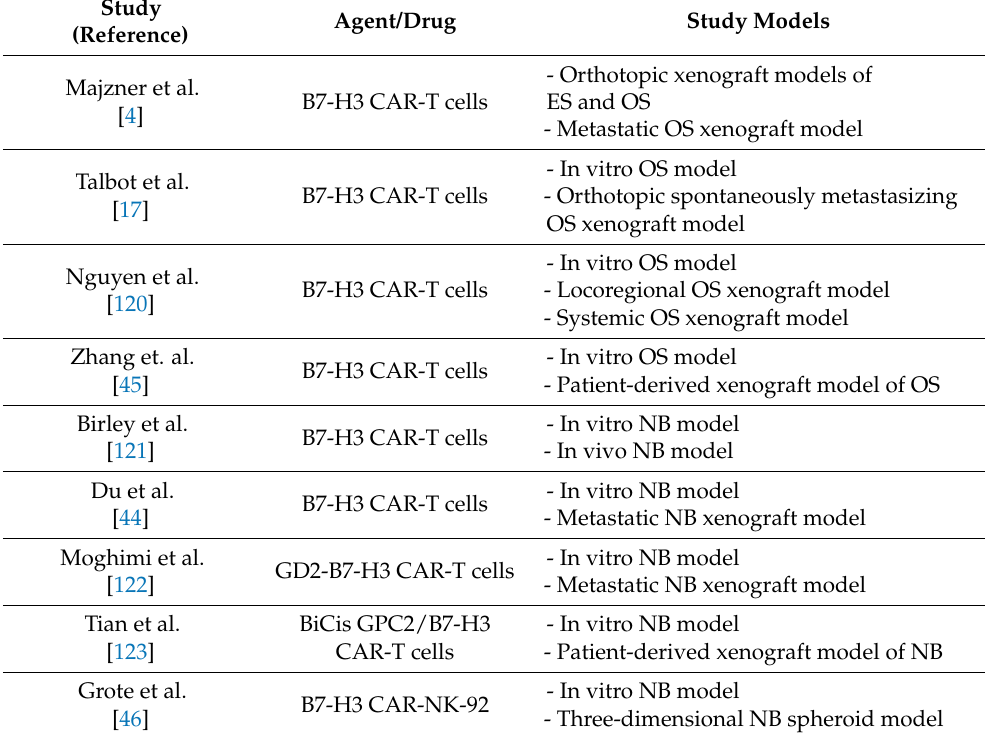
Table 3. B7-H3-targeting CAR-T cells in preclinical studies involving extracranial PSTs.